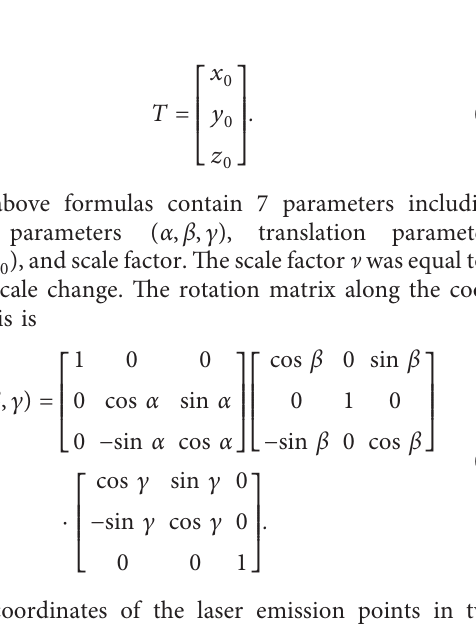
Figure 2: Principle of laser measurement. (a) Scanning line. (b) Coordinate calculation of point